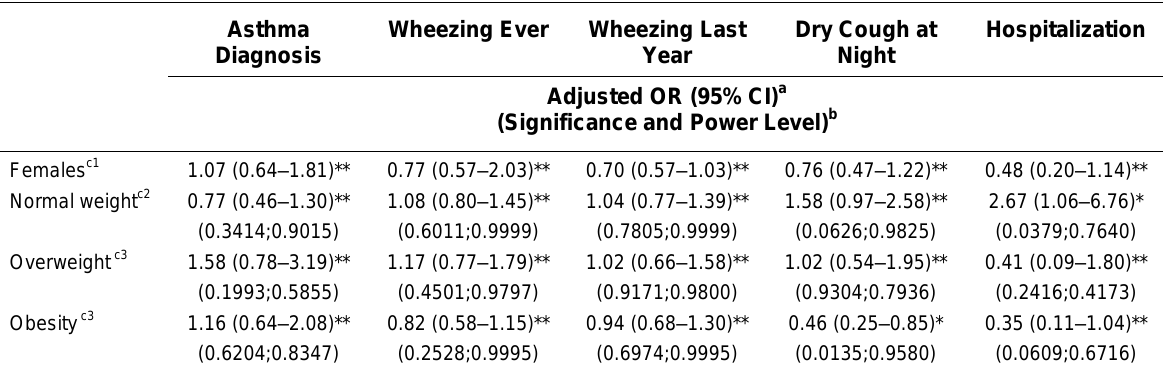
Association between Overweight, Obesity, and Asthma-Associated